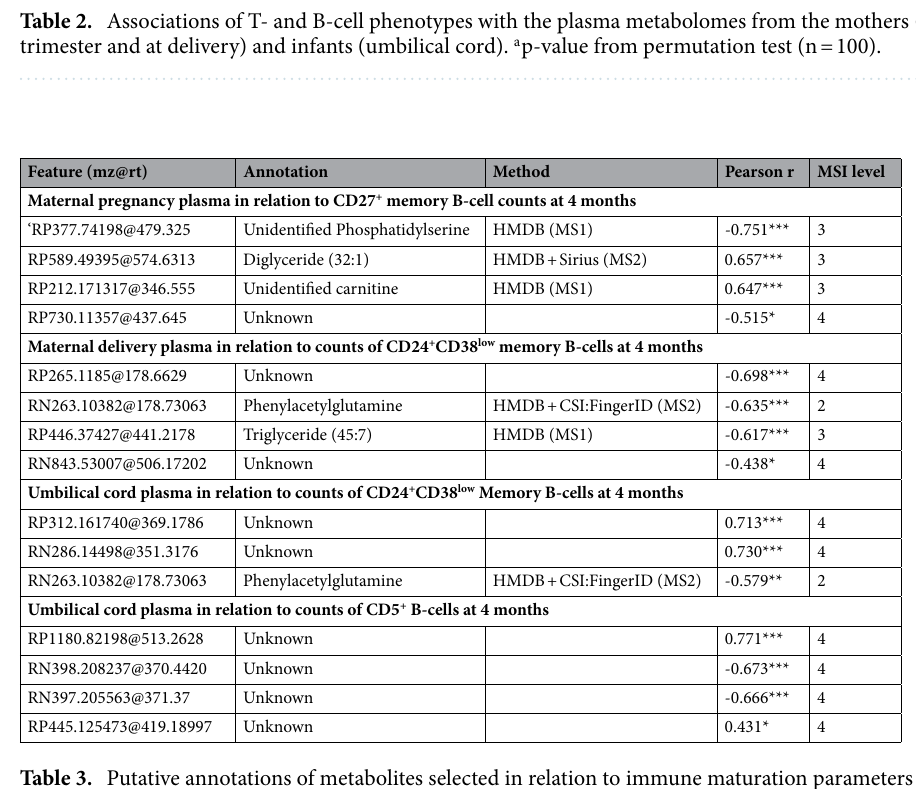
Table 3. Putative annotations of metabolites selected in relation to immune maturation parameters and their correlation with associated immune cell population. HMDB Human Metabolome DataBase, MSI Metabolomics Standard Initiative, mz mass over charge ratio, rt retention time, RP Reverse phase Positive, RN Reverse phase Negative. *p < 0.05, **p < 0.01, ***p < 0.001.